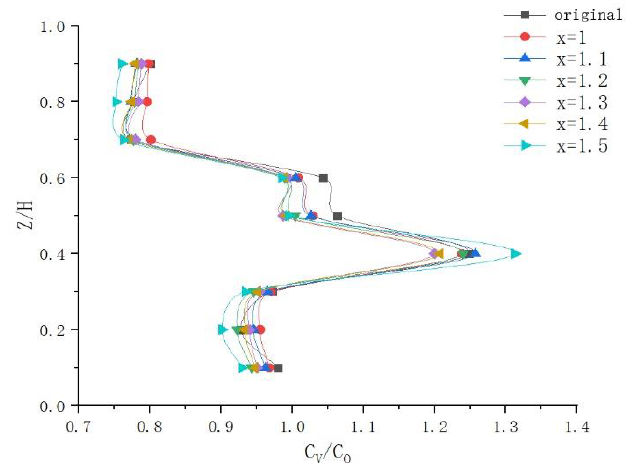
Figure 15. Optimization of the scale-up index at 5% v/v .